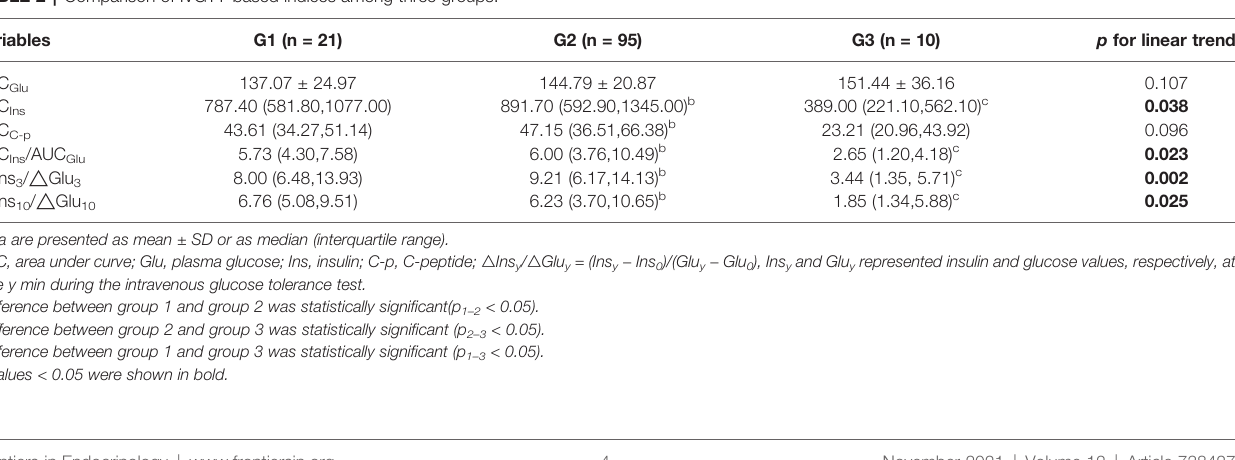
insulin curve shapes. According to our results, glucose peak at